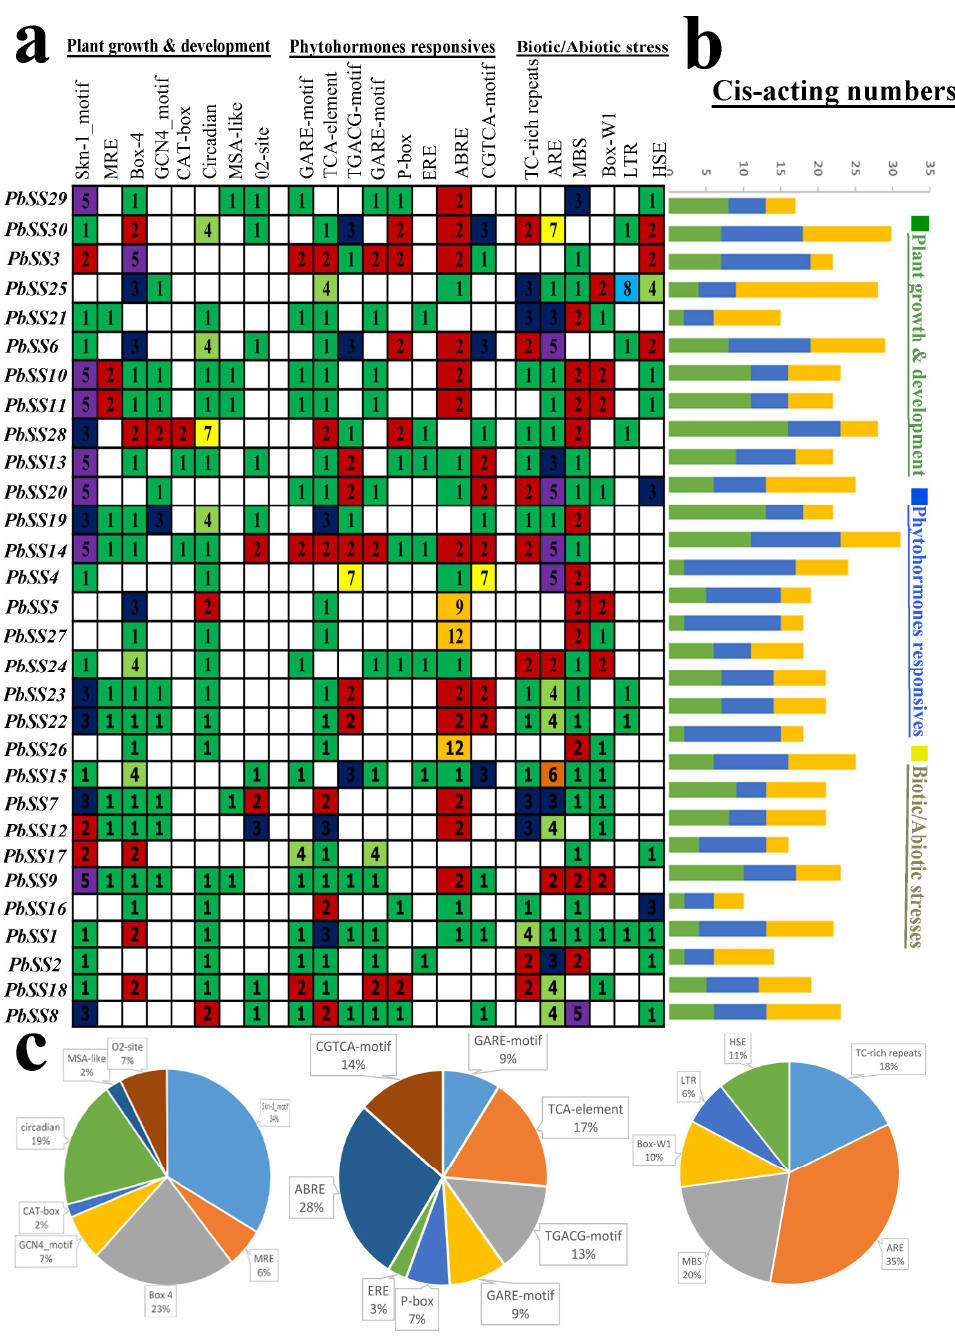
Figure 5. Investigation of cis -acting element numbers in all sucrose synthase genes of pear. ( a ) The different colors and numbers of the grid indicated the numbers of different promoter elements in these sucrose synthase genes. ( b ) The different colored histogram represented the sum of the cis -acting elements in each category. ( c ) Pie charts of different sizes indicated the ratio of each promoter element in each category, respectively.